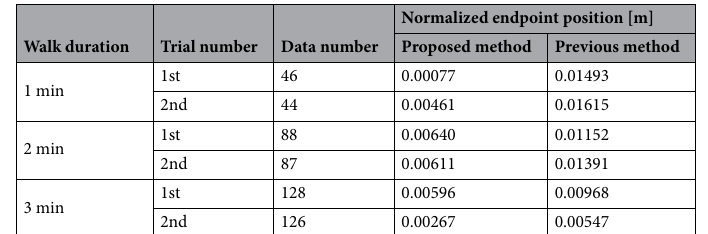
Table 6. Results of the estimation error in the normalized endpoint position between the proposed method and the previous method with 1 min, 2 min, and 3 min walk.